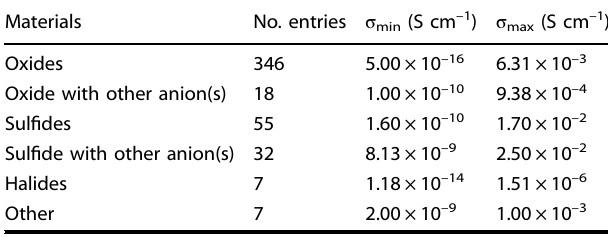
The minimum and maximum Li ion conductivities at room temperature are given for each